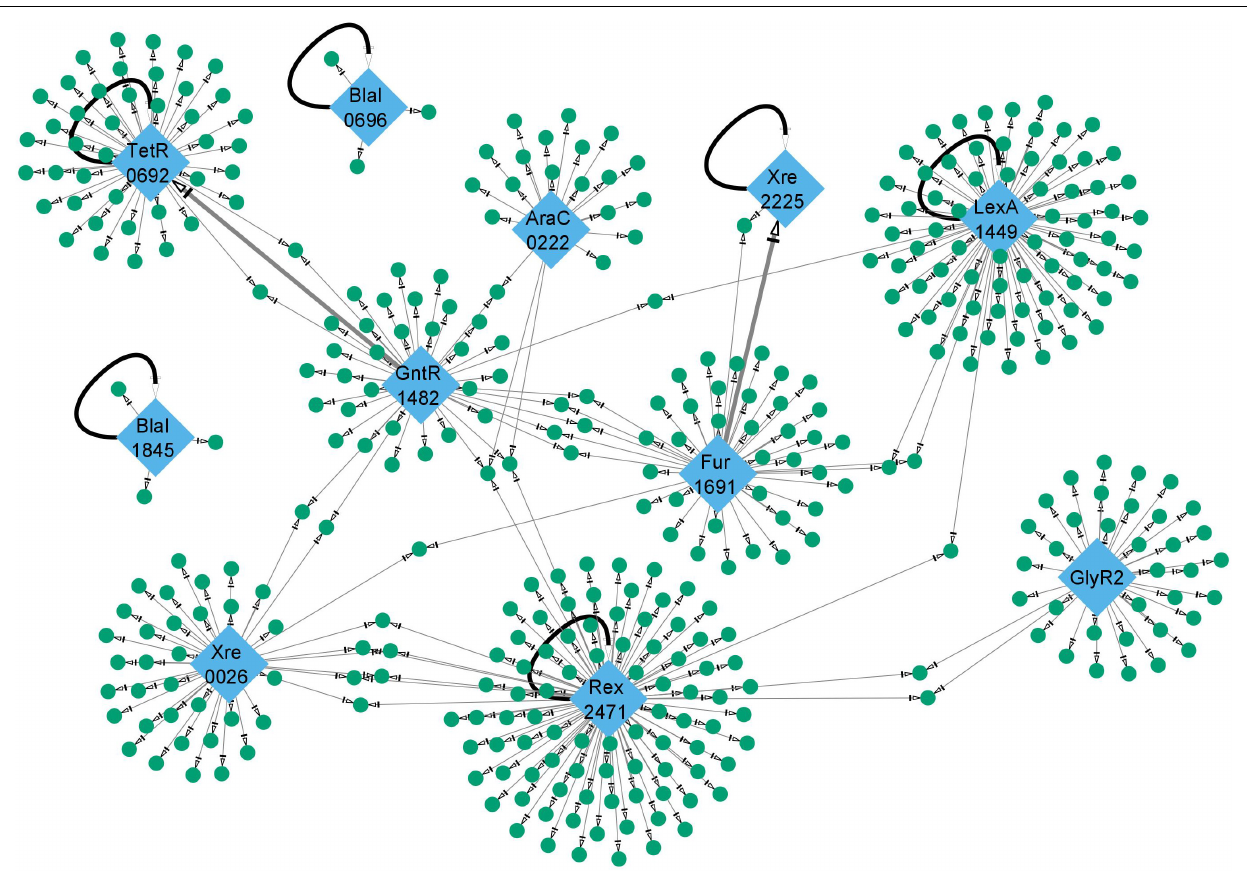
FIGURE 6 | Size and interconnection of gene regulatory networks in this work. The gene regulatory networks described in the main text are shown. Transcription factors are shown as blue diamonds and target genes as green circles. The two BlaI TFs (BlaI_0696 and BlaI_1845) and Xre_2225 regulate small subnetworks while Rex_2471 and LexA_1449 regulate a much more expansive set of genes. These five TFs mentioned so far, along with TetR_0692, appear to repress transcription of their own gene as depicted by bold black curved arrows. Two bold gray arrows indicate potential hierarchical regulatory interactions between TFs characterized in this study (GntR_1482 acting on TetR_0692, and Fur_1691 acting on Xre_2225). The complete network can be viewed in Supplementary File 1 and Supplementary Table 2